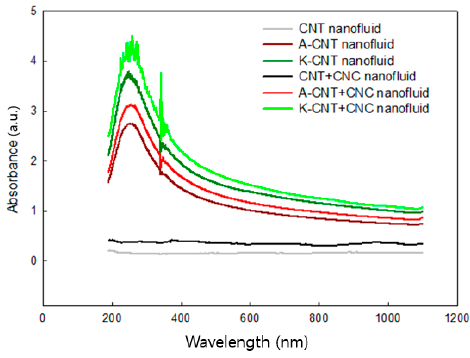
Figure 5. Absorbance measurements of the pristine MWCNTs, surface modified MWCNTs, and surface modified MWCNTs with CNC. modified MWCNTs with